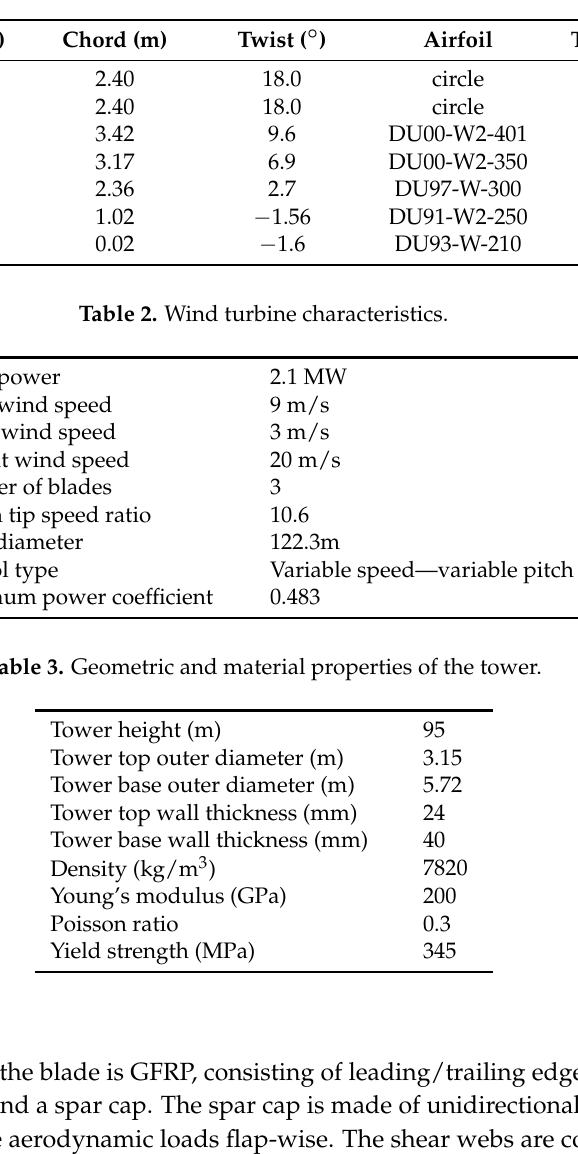
Table 1. Baseline blade geometry.